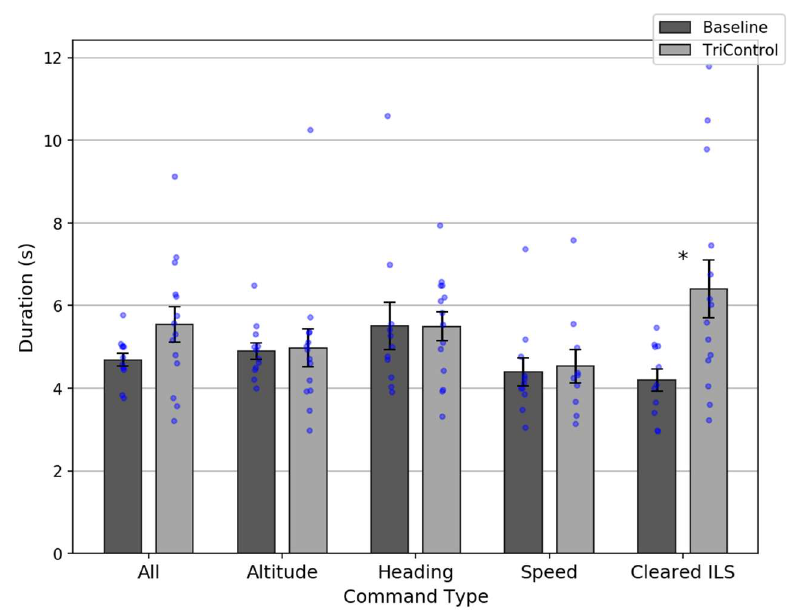
Figure 6. Baseline vs. TriControl command duration. Error bars represent ±1 standard error of the mean. Blue dots represent individual controllers.